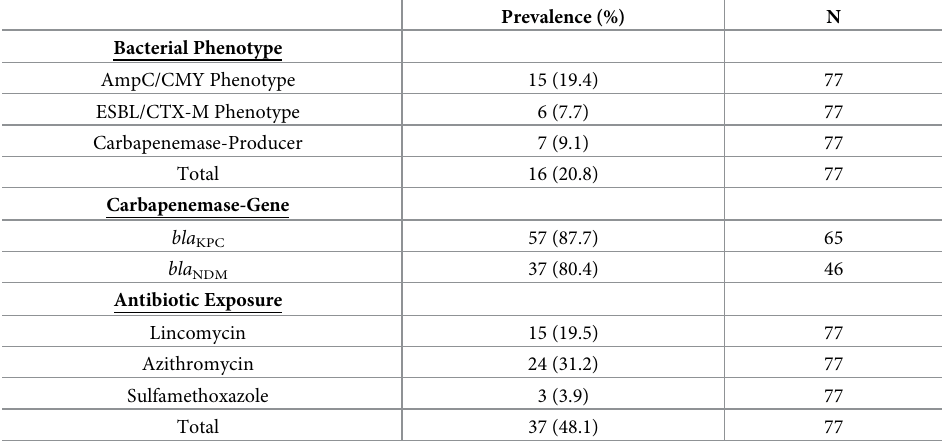
Table 1. Prevalence of fish harboring ARB and ARG in their intestinal contents and antibiotics in their hepatic